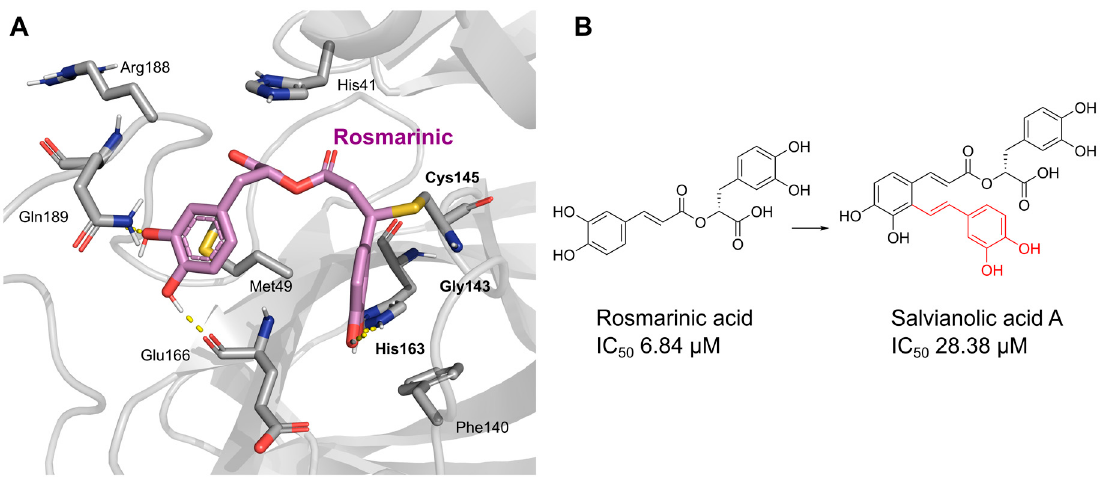
Figure 7. Rosmarinic potential binding mode within the M pro catalytic binding site ( A ). Dashed yellow lines represent polar contacts such as hydrogen bonds. The introduction of 3,4-dihydroxy phenyl acrylate in rosmarinic acid led to salvianolic acid, which reduced the activity ( B ).